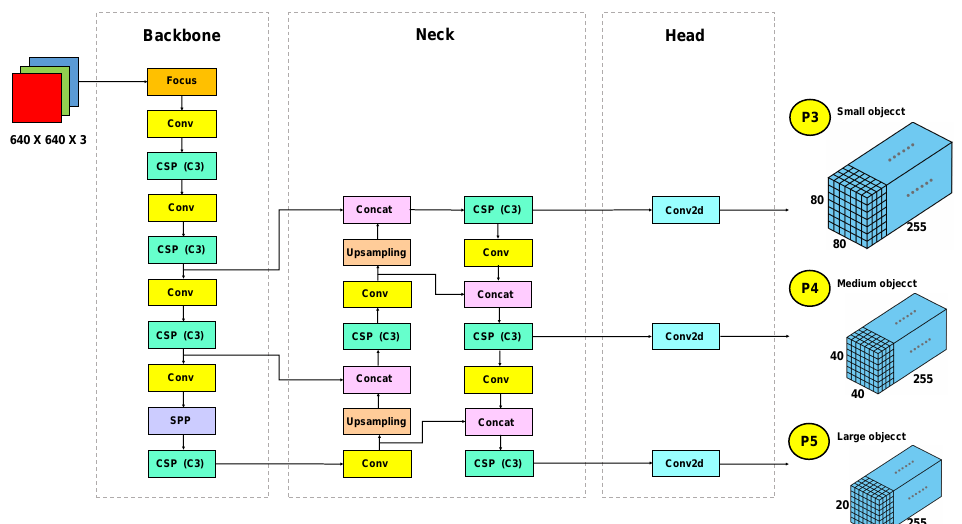
Figure 3. The neural network architecture block diagram composes the proposed approach for detecting fundus lesions. The structure is divided into three main blocks: Backbone , Neck and Head . The Backbone block consists of a Focus module, four Conv modules, four CSP modules (C3), and an SPP module. The Neck block consists of four Conv modules and four CSP modules (C3). The network input receives images of size 640 × 640 × 3, and the output is composed of three detection heads: the P3 layer, responsible for detecting small objects; layer P4, responsible for detecting medium objects; and, finally, the P5 layer, responsible for detecting large objects. CSP (C3), Cross Stage Partial